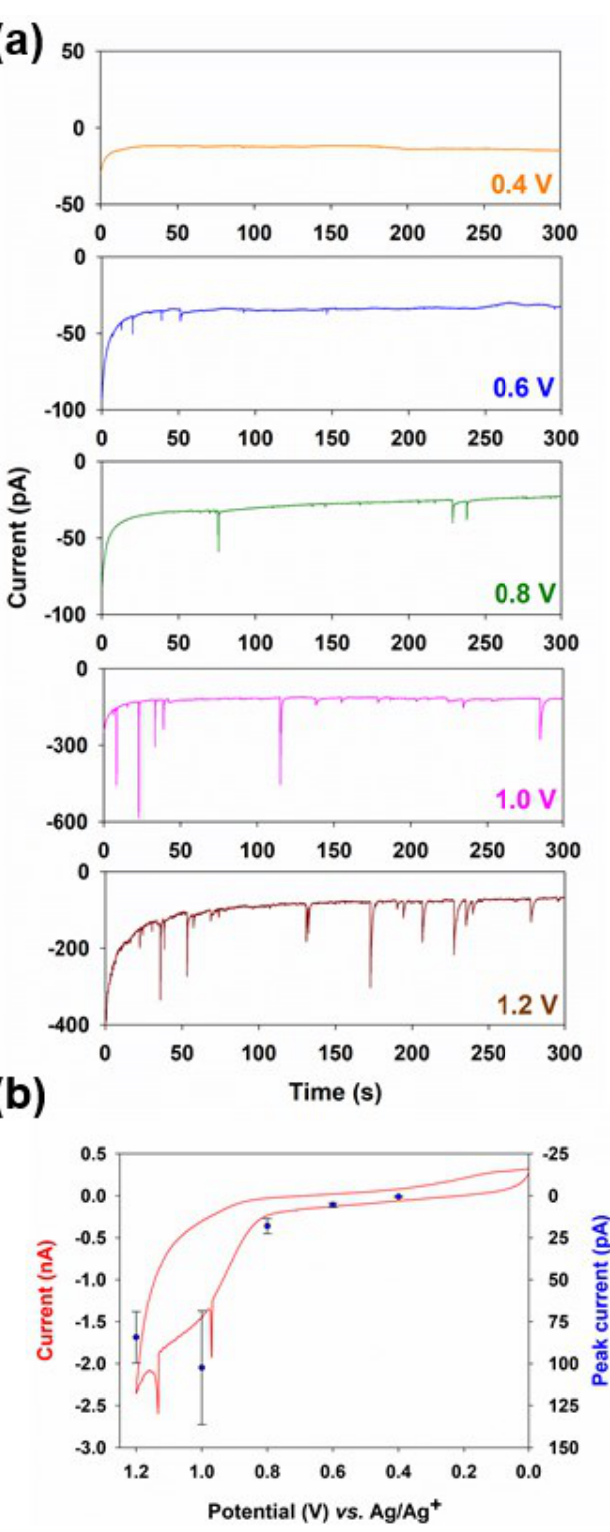
Figure 2. ( a ) Amperometric i–t curves of W/O emulsion droplet on Pt-UME at various applied potentials (0.4, 0.6, 0.8, 1.0, and 1.2 V vs. Ag/Ag + ) in DCE electrolyte solution containing 10 mM TBABF 4 ( b ) Collisional peak heights obtained from W/O emulsion in the DCE electrolyte solution were plotted together with a cyclic voltammogram of the same solution depending on the applied electrode potentials.